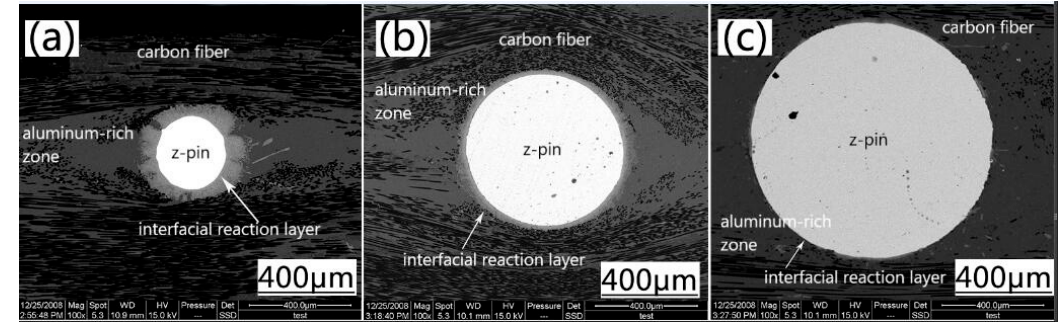
Figure 3. Microstructures of z-pinned Cf/Al composites with different diameters of metal pins ( a ) φ 0.3 mm, ( b ) φ 0.6 mm and ( c ) φ 0.9 mm.